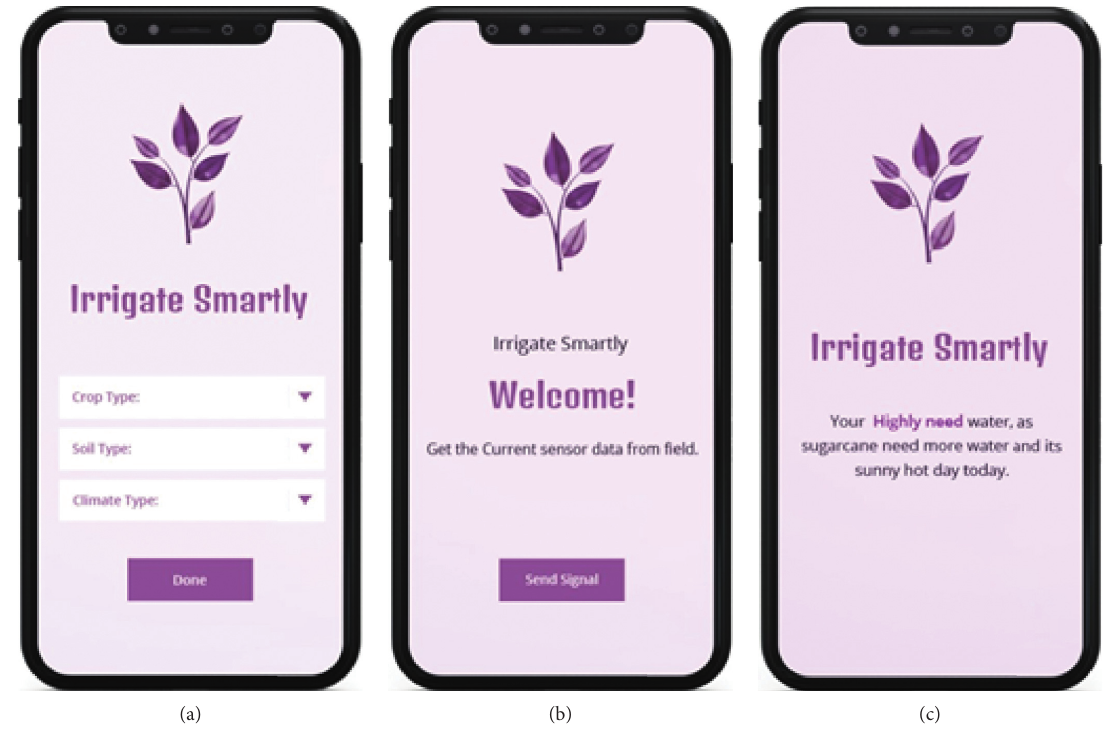
Figure 13: Android app different interfaces (a, b, and c). Table 4: Codes for class